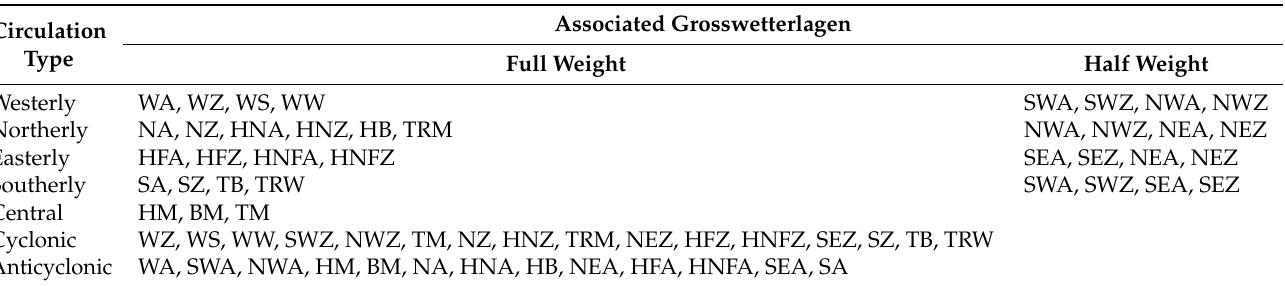
Table 2. Definition of the circulation types and their associated atmospheric circulation